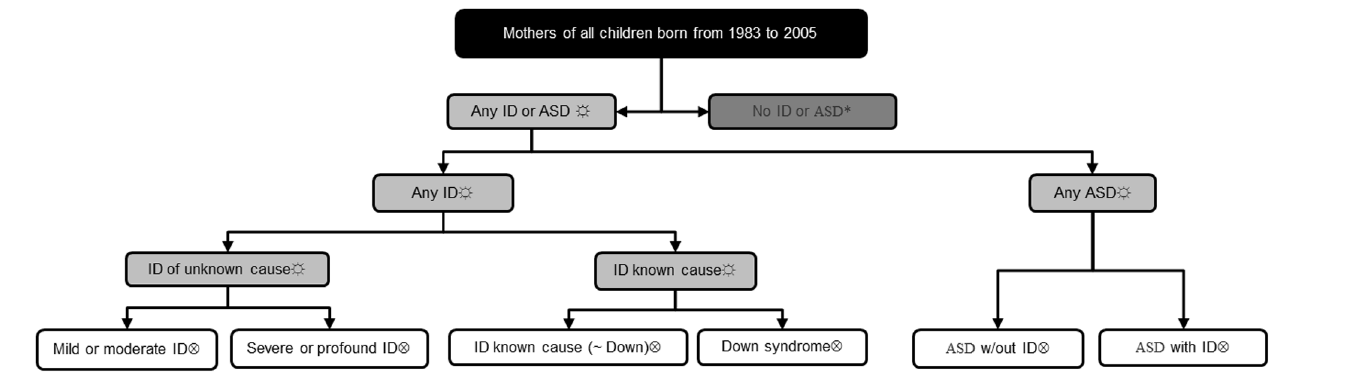
Fig. 1. Comparison group, composite and core case